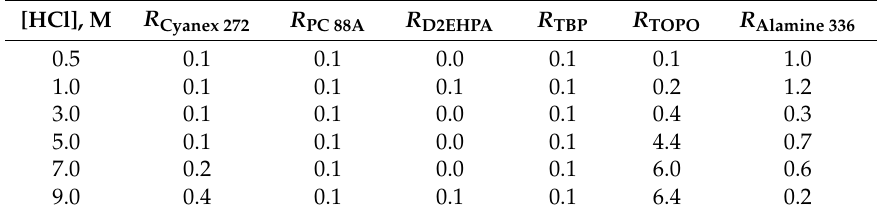
Table 4. Synergisticenhancementcoefficient( R )ofPd(II)withmixtureofCyanex301andvariousextractants. [HCl], M R Cyanex 272 R PC 88A R D2EHPA R TBP R TOPO R Alamine 336